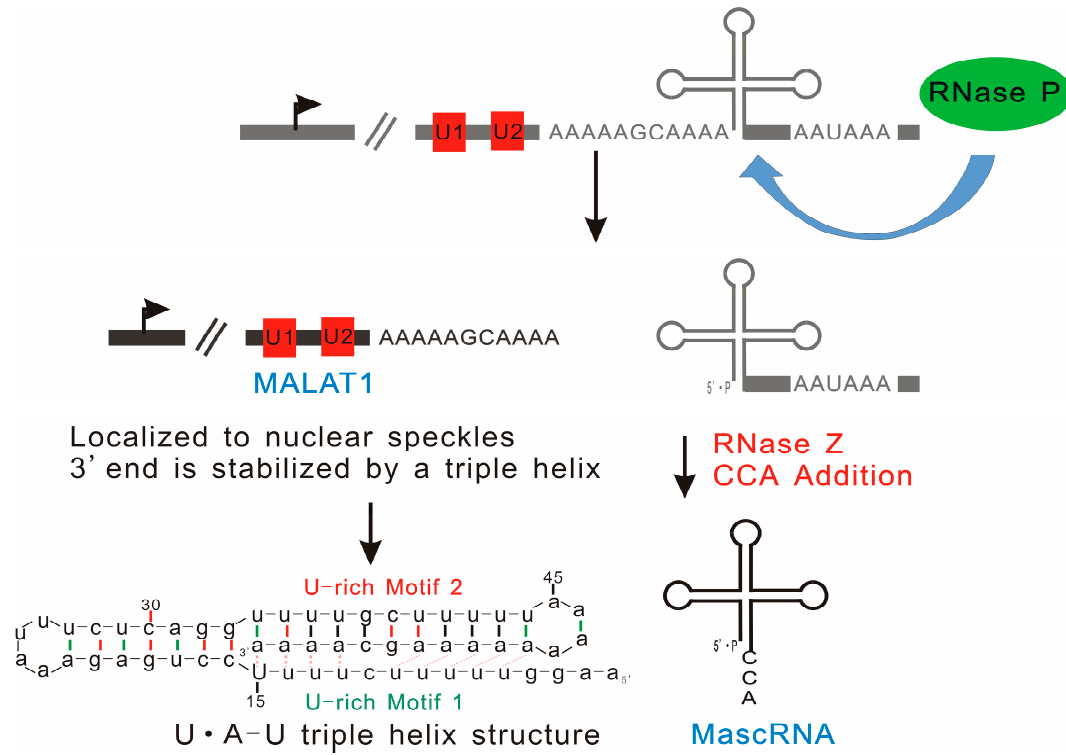
Figure 5. Triple helix structure of MALAT1 explains its high stability. RNase P is involved in the generation of the 3’ end of MALAT1 and the 5’ end of tRNA-like cytoplasmic RNA designated as mascRNA. A triple helix (U•A-U) formed by the conserved poly(A)- and its flanking U-rich motifs prevents the degradation of MALAT1 by exonucleases.